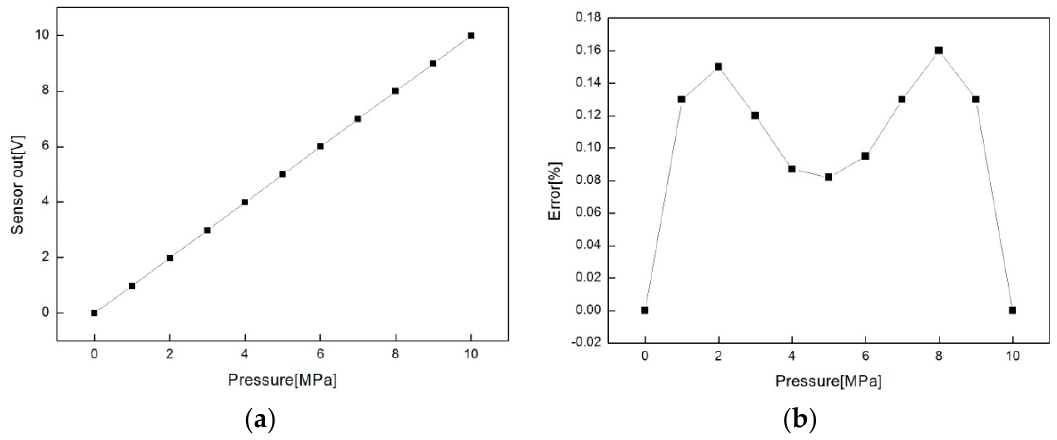
Figure 14. Pressure sensor output ( a ) and linearity error ( b ) along with applied pressure Table 3. Measurement results of the assembled sensor according to varied pressure.